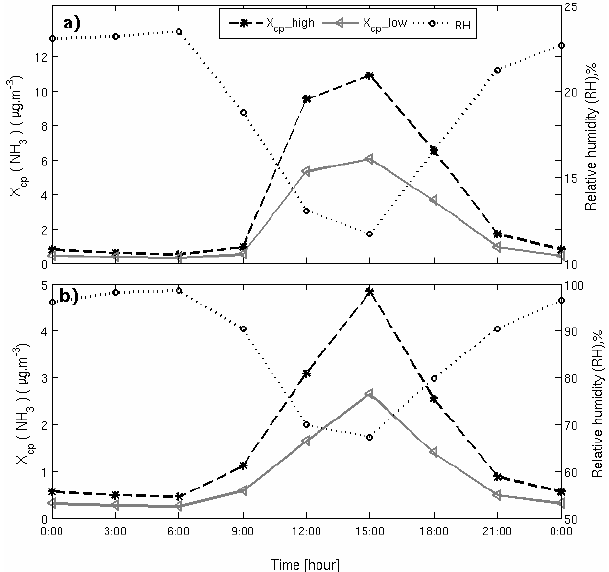
Fig. 3 . Mean diurnal variation of the simulated NH 3 canopy compensation point X cp (NH 3 ) for two Fig. 3. Mean diurnal variation of the simulated lower (low flux) and scenarios (high, low), associated to the variation of the relative humidity (RH) at a Sahelian site ( a , upper (high flux) NH 3 canopy compensation point X cp (NH 3 ) asso- Banizoumbou) and a Guinean savanna site ( b , Lamto ) in the dry season (January, 2006). ciated with the variation of the relative humidity (RH) at a Sahelian site ( (a) Banizoumbou) and a Guinean savanna site ( (b) Lamto) in the dry season (January,